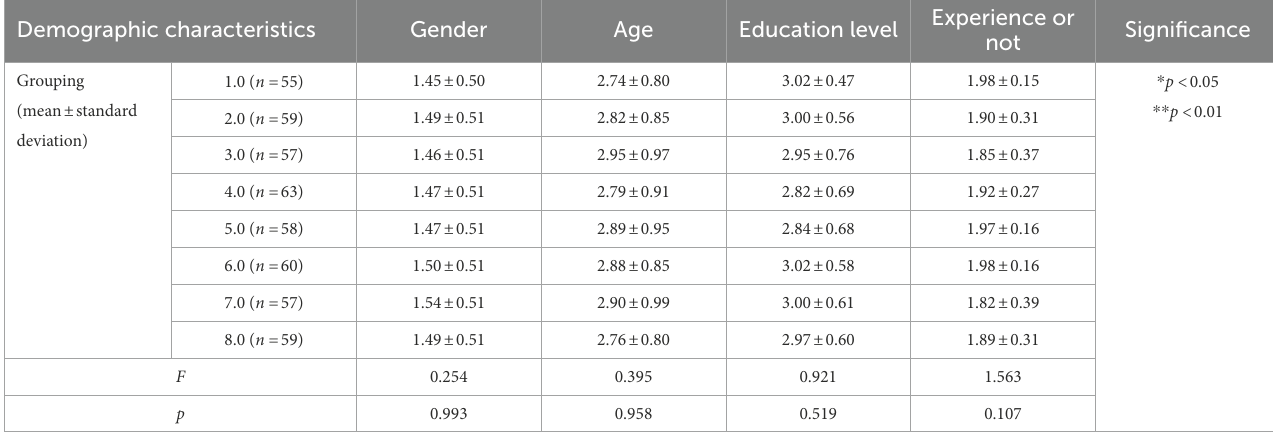
TABLE 8 One-way ANOVA results of demographic characteristics of each scenario